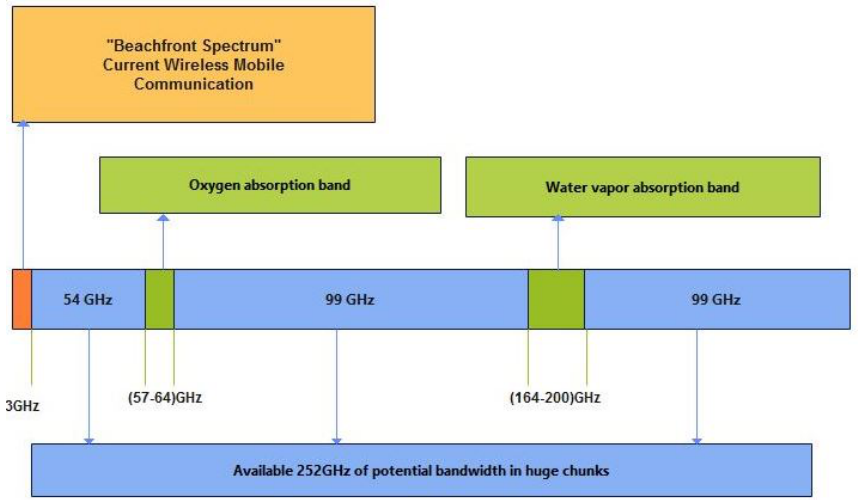
Figure 12. Available mm-wave Communication Spectrum (3 GHz–300